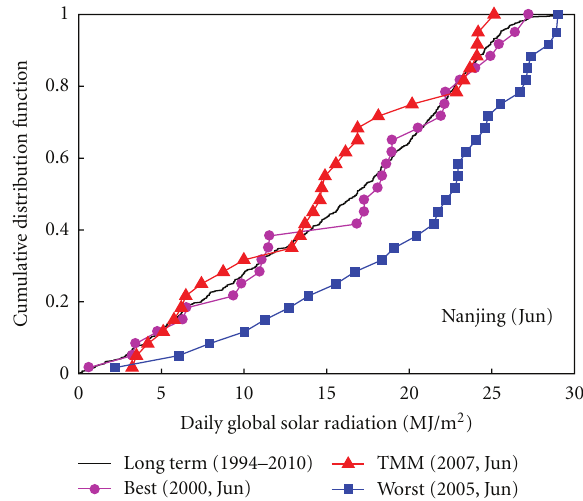
Figure 1: CDFs for June daily global solar radiation for